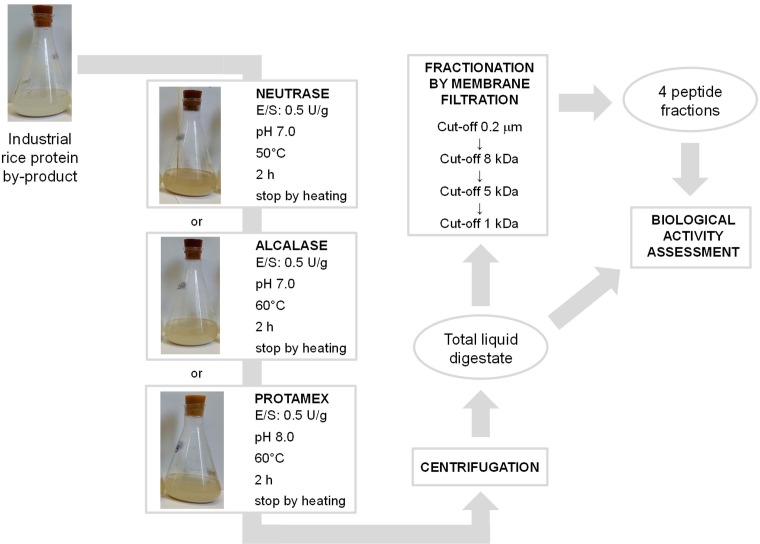
Schematic representation of the proposed process.Rice protein by-product from starch industry was enzymatically hydrolysed by one of the three selected commercial proteases at the defined conditions. The resulting liquid supernatant was fractionated by a sequence of four cross-flow membrane filtrations at different molecular weight cut-offs, leading to the isolation of different peptide ingredients.